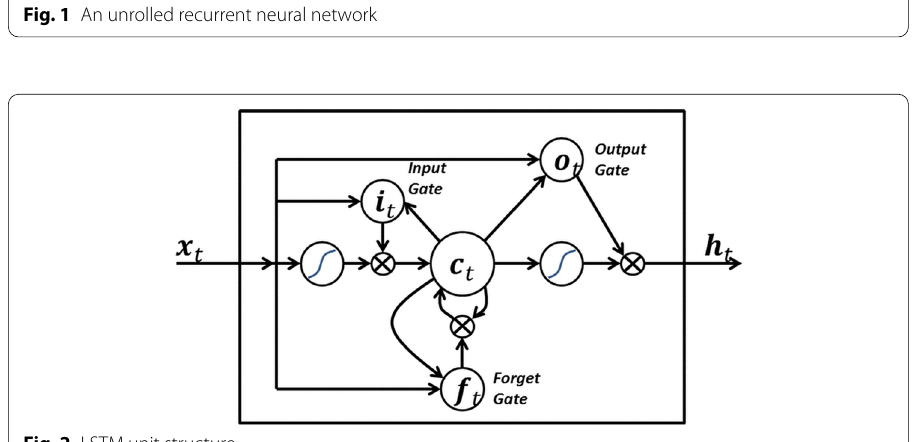
Fig. 2 LSTM unit